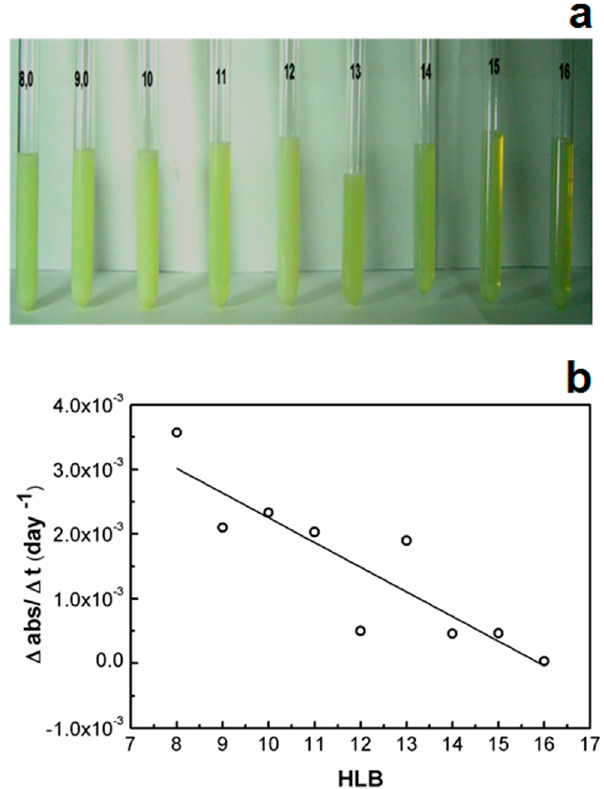
Figure 1. ( a ) Transparency at 24 h and ( b ) turbidity variation during 30 days as a function of the SPC/SO ratio at different HLB. Note: the samples contain MCT (10% w / w ), SPC/SO (10% w / w ) and purified water (80% w / w ).